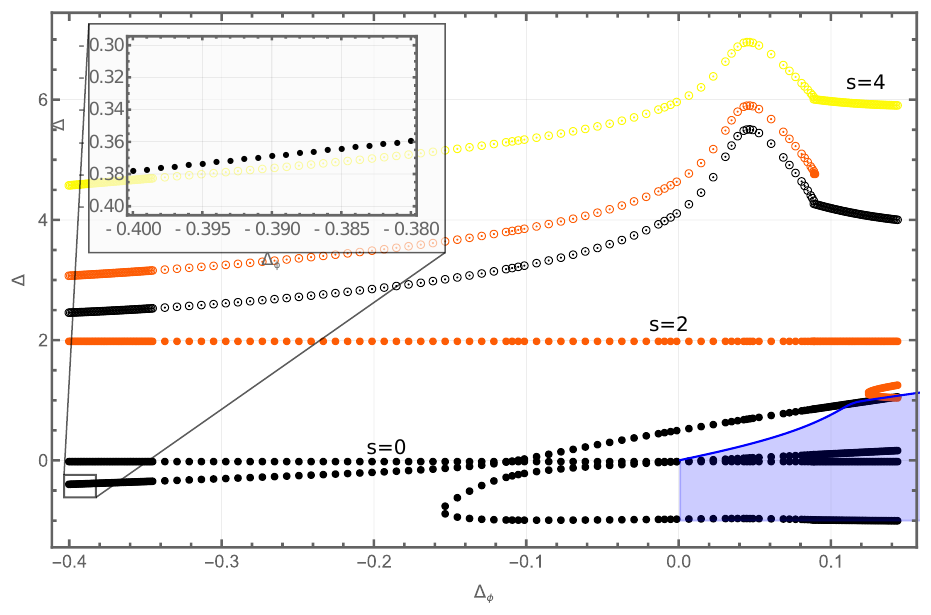
Figure 7 . Roots of the extremal functional evaluated at decreasing values of the ∆ φ after the addition of a double root at spin 2. Single roots are denoted by filled circles and double roots are denoted by dotted circles. The blue curve Shows the extermal scalar gap obtained using semidefinite